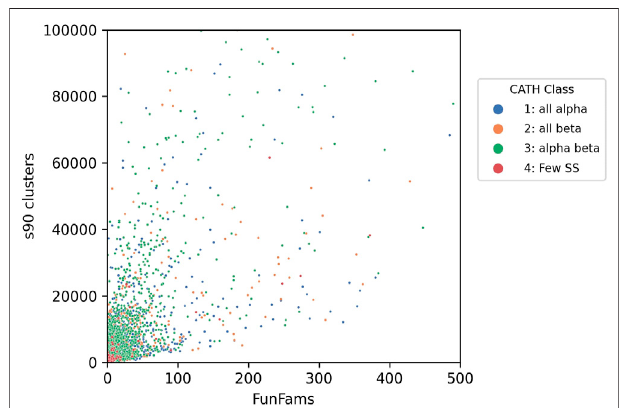
FIGURE 9 | Functional diversity (captured by number of functional families - FunFams) vs. sequence diversity (number of Gene3D s90 clusters i.e. in which relatives share 90% or more sequence identity) for CATH superfamilies. Each dot represents an individual